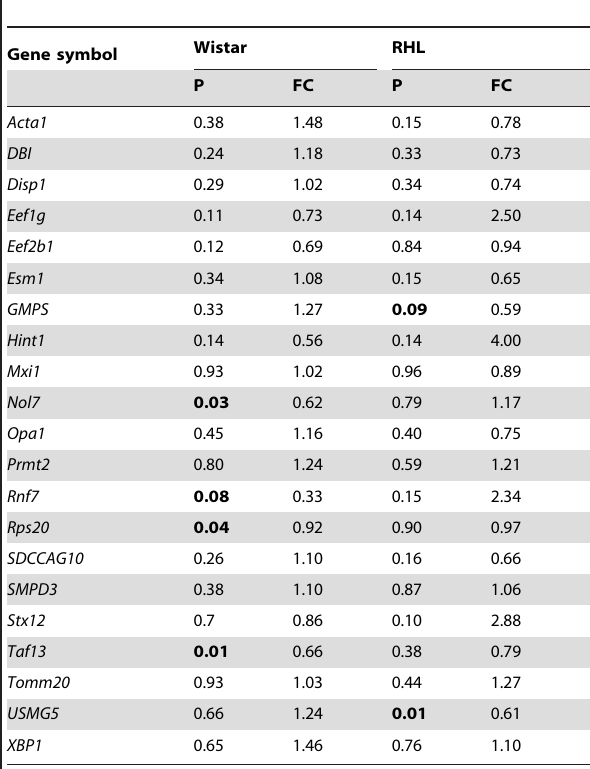
Table 3. Expression of selection of microarray genes in embryonic tissue analysed by real-time PCR in response to iron deficiency in both Wistar and Rowett Hooded Lister rats (FC=fold-change, RHL =Rowett Hooded Lister).